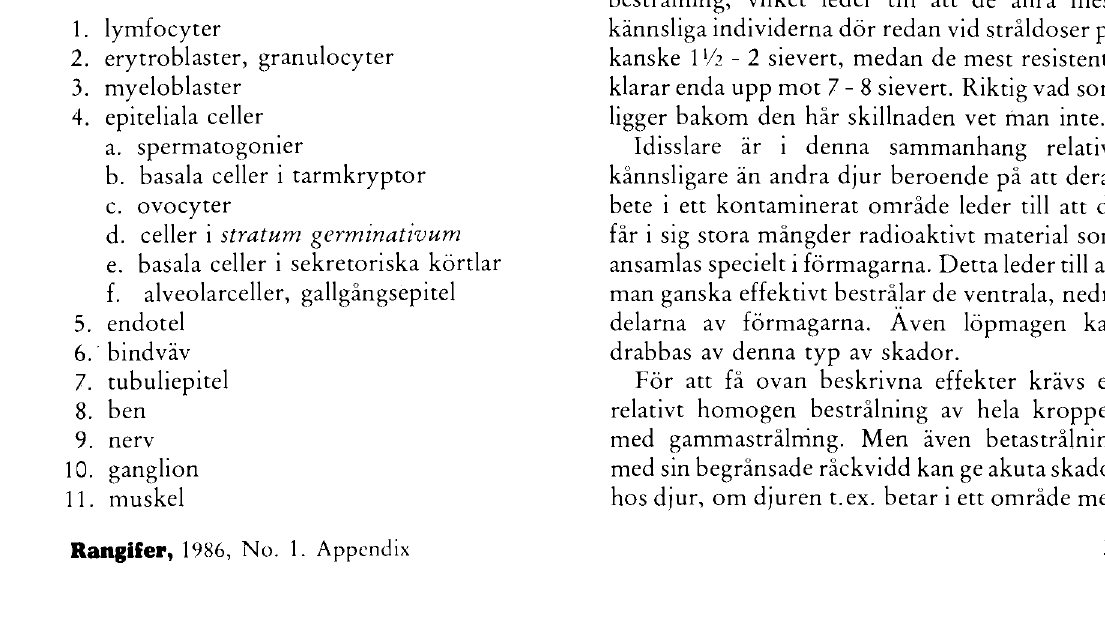
Tabell 1. Olika cellers och våvnaders kånslighet for Bergonie-Tribondeaus'